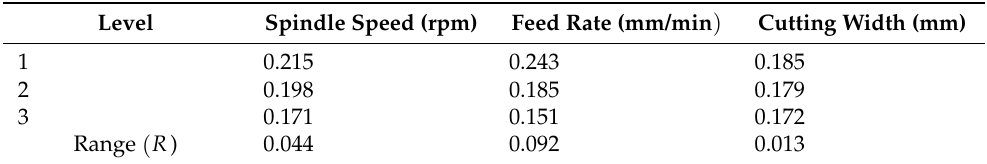
Figure 15. Surface morphology at different cutting parameters in orthogonal experiments. Table 6. Two-factors/four-levels and one-factor/three-levels orthogonal experimental significance analysis of average length of tearing L